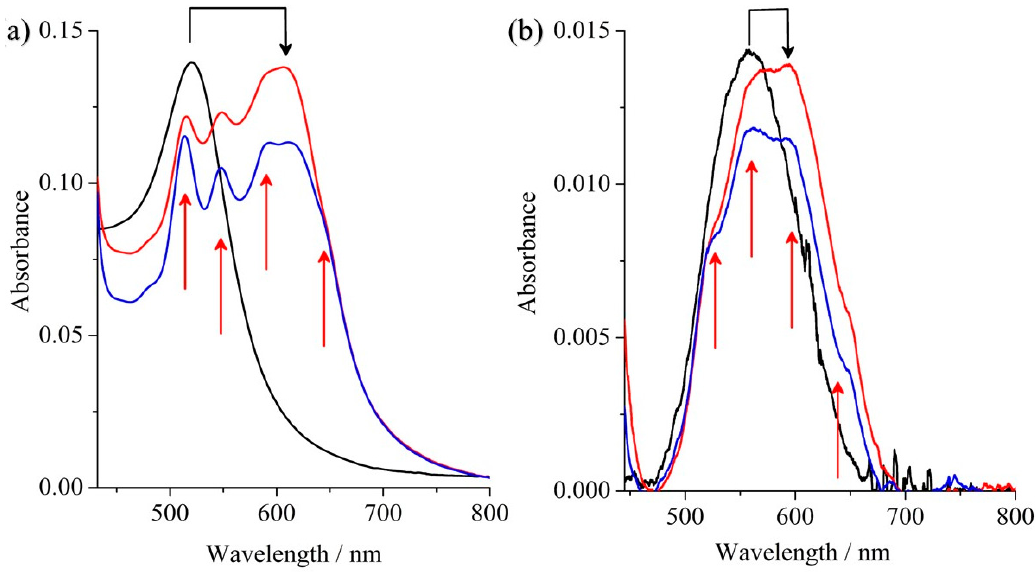
Figure 11. UV–vis absorbance spectra of ( a ) 100 µL of an Au NPs aqueous 1.97 × 10 − 7 M solution diluted with 2 mL of CH 3 OH (black line), upon the addition of 240 µL of a 2.07 × 10 − 5 M porphyrin CH 3 OH solution (red line, corrected for the volume variation), and upon the addition of 450 µL of a 2.07 × 10 − 5 M porphyrin CH 3 OH solution (blue line, corrected for the volume variation), and of ( b ) the centrifuged same Au NPs–porphyrin solution deposited on quartz substrates, in the 430–850 nm wavelength range. The red arrows indicate the four Q-bands at 513.6, 547.8, 590.6, and 642.0 nm and the black arrow indicates the Au NPs surface plasmon resonance that, in solution, moved from 520.4 to 612 nm and on quartz substrates moved from 559 to 595 nm.